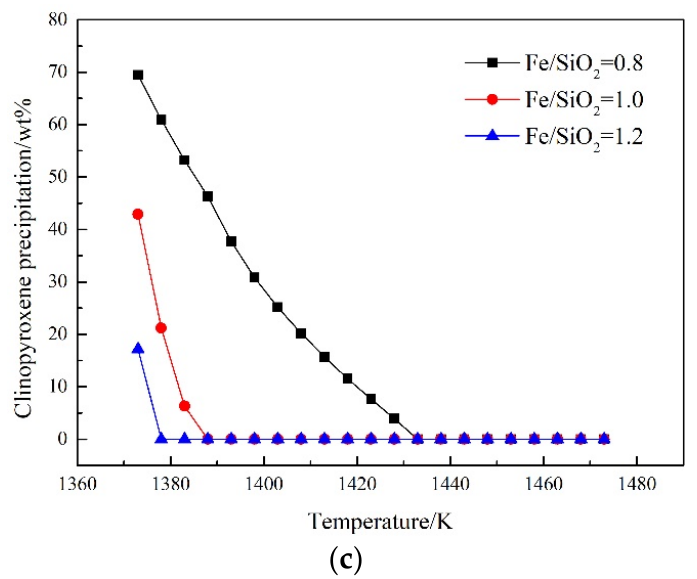
Figure 4. Effect of Fe/SiO 2 ratio on the cooling precipitation of crystalline phase at 1373–1473 K for 4 wt% Fe 2 O 3 content of ( a ) spinel; ( b ) fayalite; ( c ) clinopyroxene.